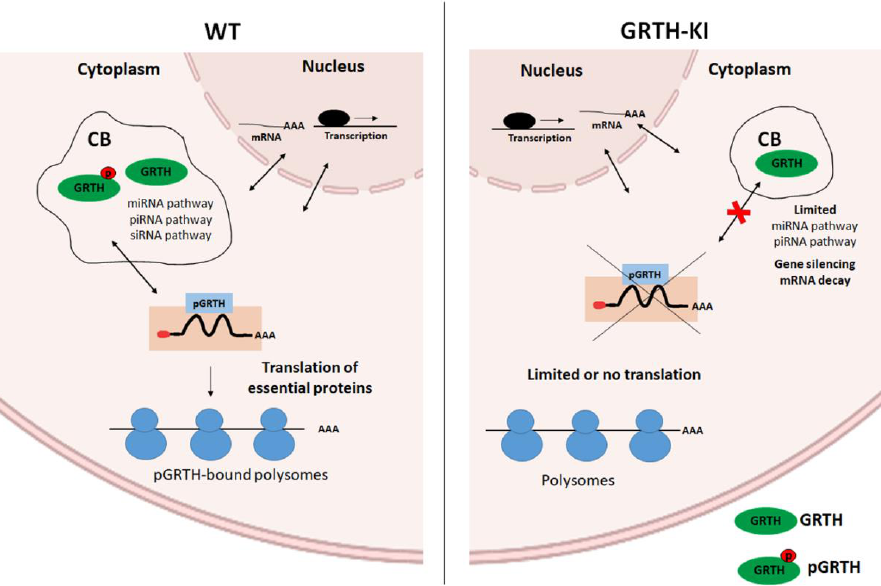
Figure 5. RNA transport and associated changes occurring in CBs of GRTH-KI mice compared to wild-type mice. GRTH transports essential mRNAs from nucleus to the cytoplasm for translation. The pGRTH, through its interaction with actively elongating polyribosomes, regulates translation of target mRNA. It is involved in transport of mRNPs in and out of the chromatoid body, where it is transiently stored and/or degraded when not needed in the CBs. mRNAs are transported from the CB by pGRTH for translation at specific times during